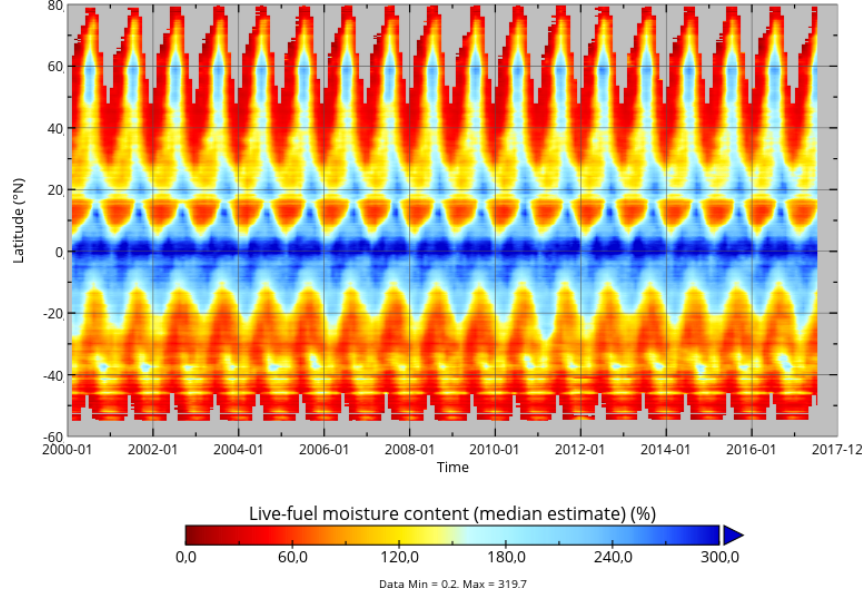
Figure 9. Hovmöller diagram of monthly LFMC as estimated from Model B using daily Ku-VOD and monthly